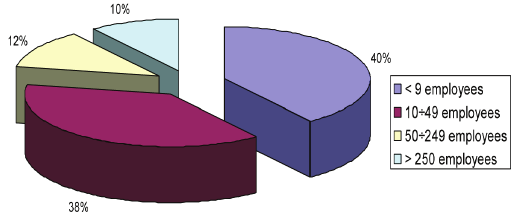
Fig. 2. Structure of enterprises according to the number of employees